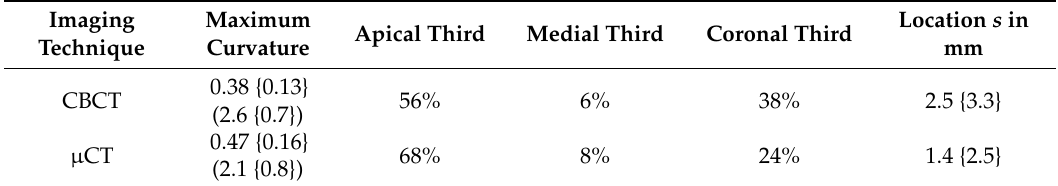
Table 3. Median and quartile deviation of the maximum curvatures and its relative probability in the di ff erent thirds ( n = 50).